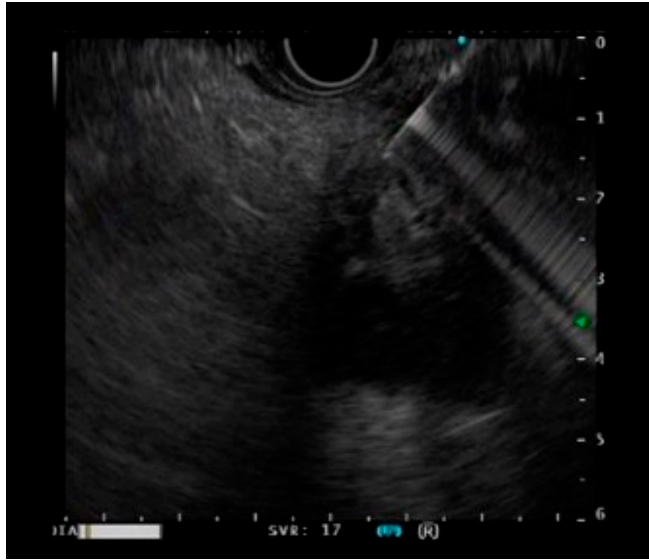
Figure 1. A case of a pancreatic tumor undergoing EUS-guided fine-needle biopsy.